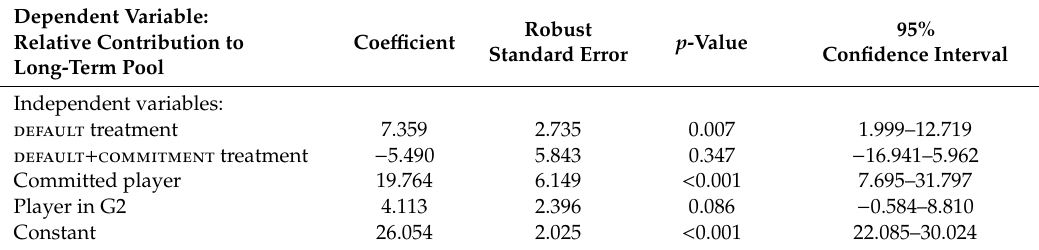
Table A2. Contributions Relative to the Individual